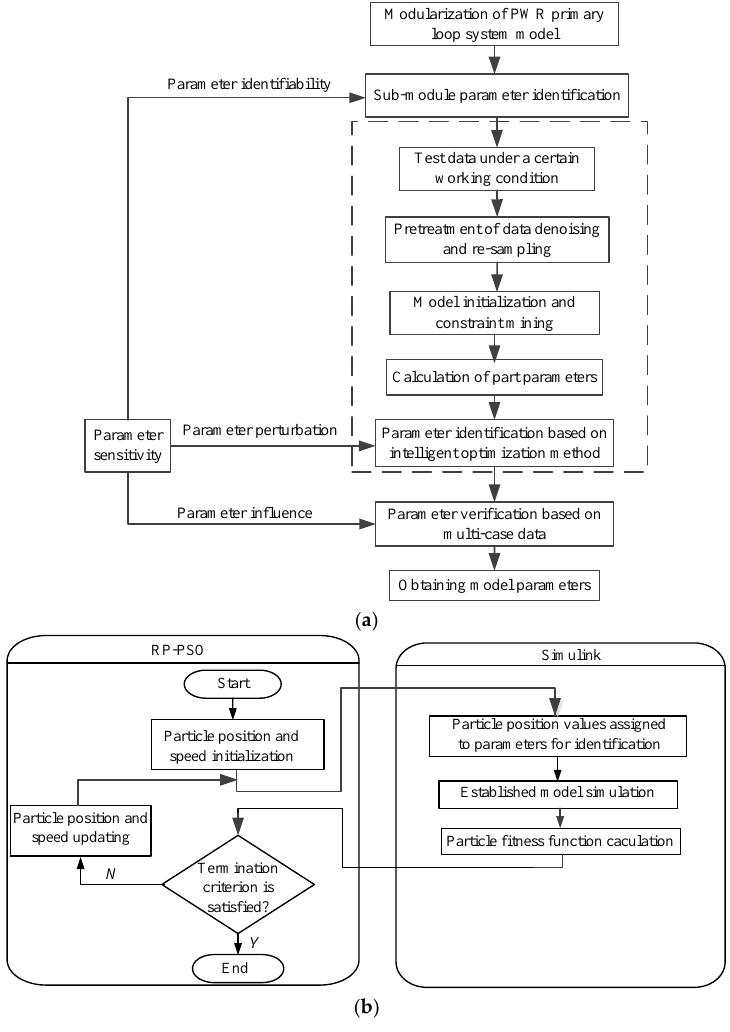
Figure 7. Nuclear power parameter identification process. ( a ) Nuclear power parameter identification process diagram; and ( b ) parameter identification process diagram with the random perturbation particle swarm optimization (RP-PSO ) and Simulink.